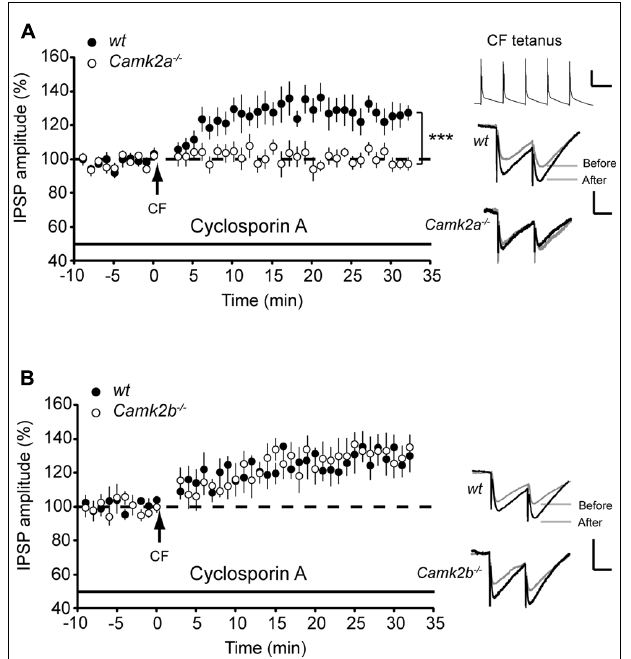
FIGURE 2 | Block of PP2B reveals iLTP and block of IP 3 disrupts rescue of iLTP in Camk2b − / − mice. (A) CF stimulation yields iLTP in wt Purkinje cells ( n = 7) in the presence of 5 μ M PP2B inhibitor cyclosporin A, but not in Camk2a − / − Purkinje cells ( n = 10). Inset: representative traces of CF stimulation, scale bars 20 mV/100 ms and representative traces of IPSP before and after the CF stimulation, scale bars 1 mV/25 ms). ( B) CF stimulation yields iLTP in wt Purkinje cells ( n = 6) in the presence of 5 μ M PP2B inhibitor cyclosporin A, as well as in Camk2b − / − Purkinje cells ( n = 8). Inset: representative traces of CF stimulation, scale bars 20 mV/100 ms and representative traces of IPSP before and after the CF stimulation, scale bars 1 mV/25 ms. Error bars represent SEM. Asterisks with brackets indicate statistical significance between wt and knockout mice (Student’s t -test of averages over last 5 min). *** p < 0.005.